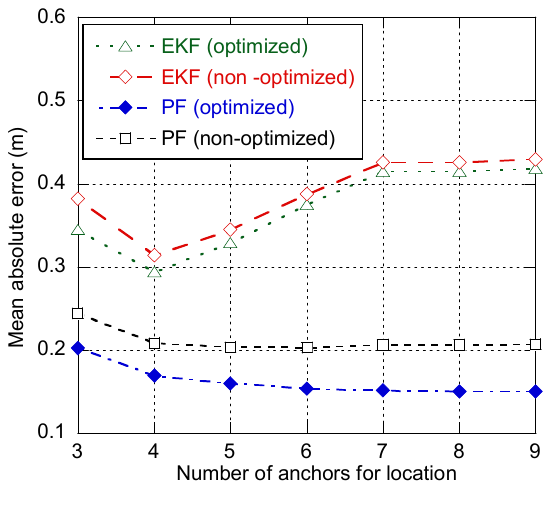
Figure 7. Impact of model optimization in EKF and PF. Distance between anchors = 10 m, σ = 0.3 m. n